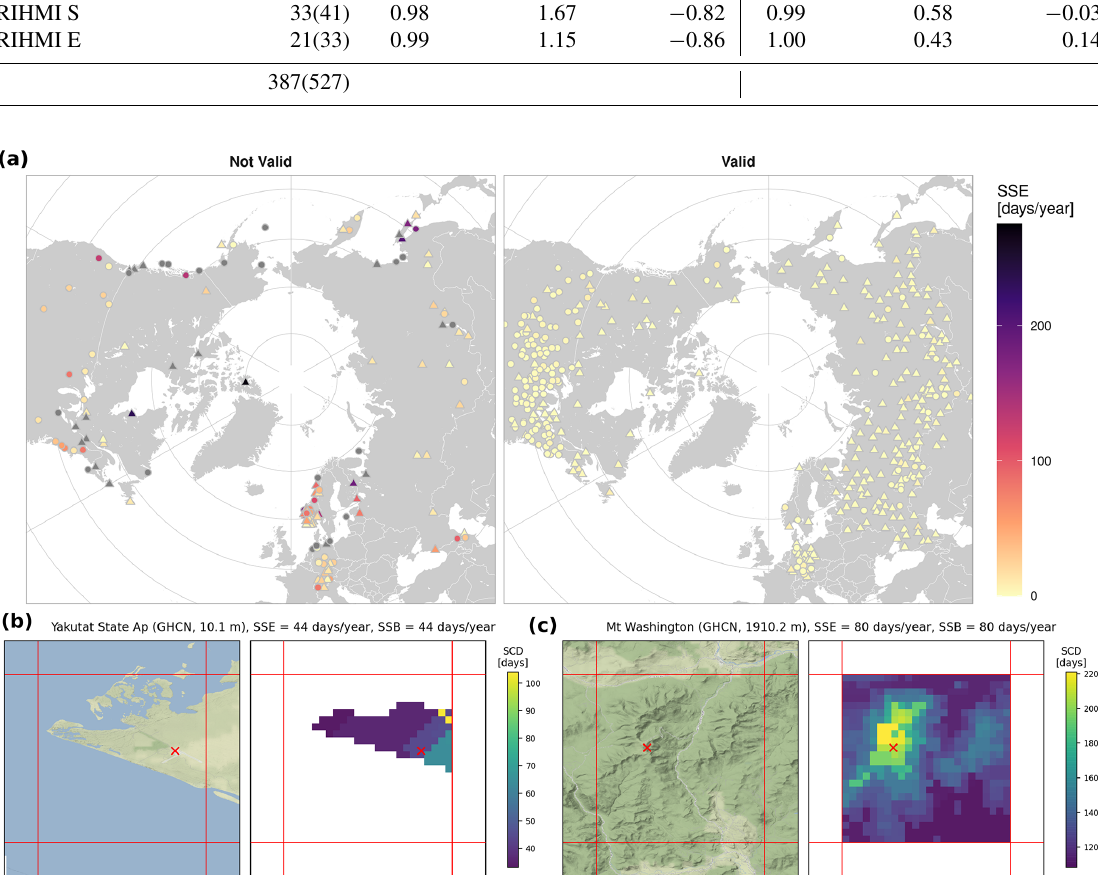
Figure 3. (a) Spatial sampling error (SSE) of in situ snow measurements with respect to ERA5 grid. Stations in gray have an IMS snow cover equal to zero. Triangles indicate stations assimilated into the ERA5 model. Spatial distribution of annual snow cover duration (SCD) from the IMS 1km product in two of the stations flagged as low spatially representative: (b) coastal station and (c) mountain station. Red lines represent the ERA5 grid. The red cross shows the station location. Terrain map tiles by Stamen Design, under CC-BY 3.0. Data by © OpenStreetMap, under